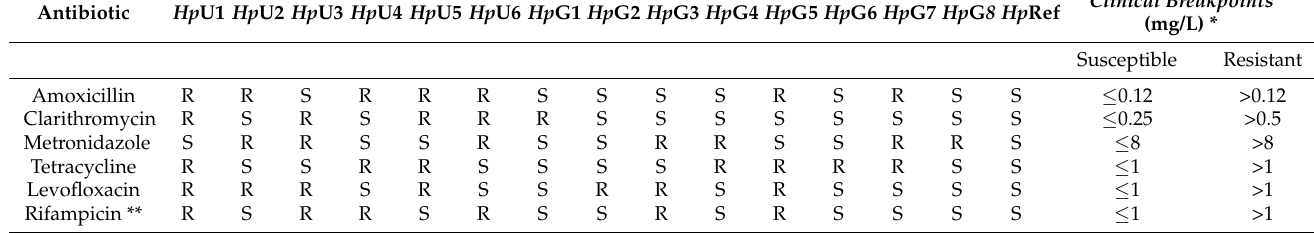
Table 2. Antibiotic susceptibility results from six antibiotics against H. pylori strains isolated from clinical samples (ulcers = 6, gastritis = 8) and a reference strain ( H. pylori